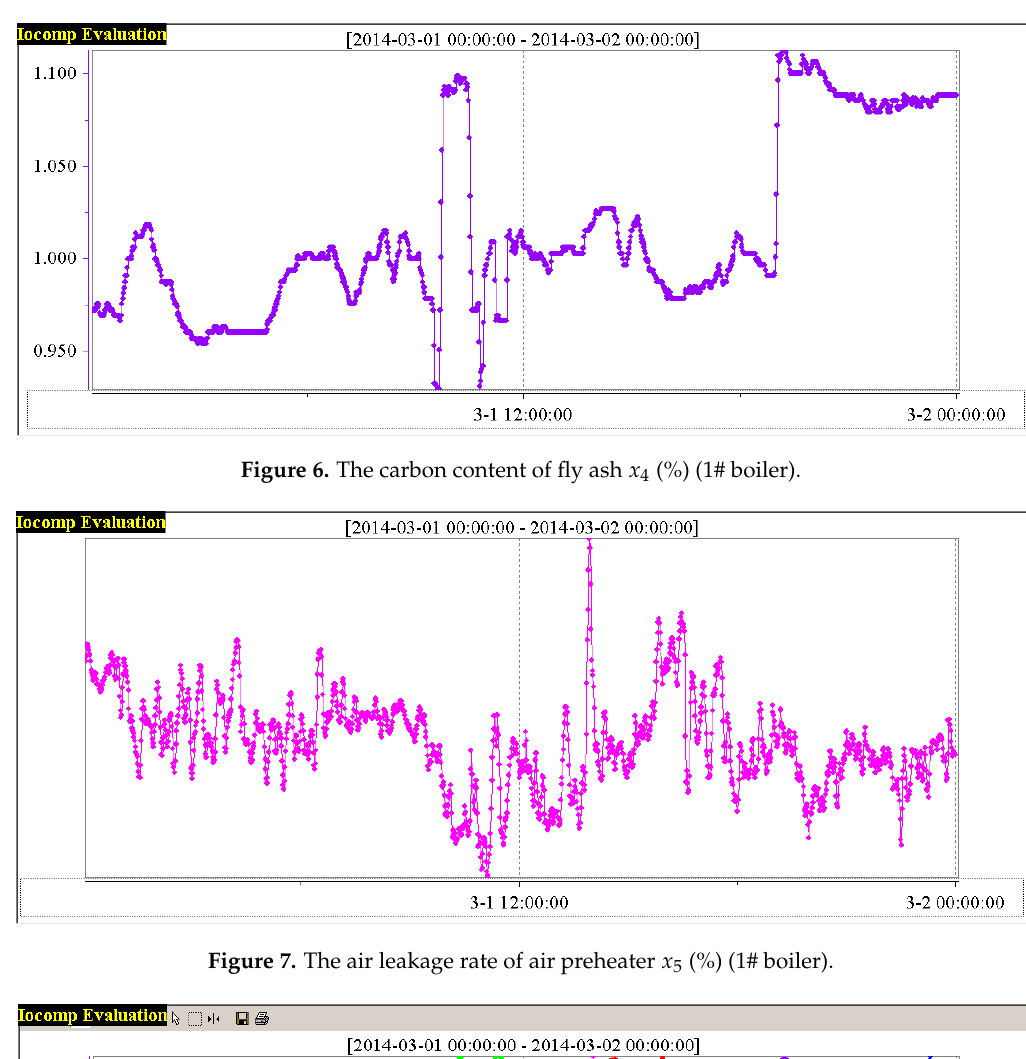
Figure 5. The boiler oxygen content